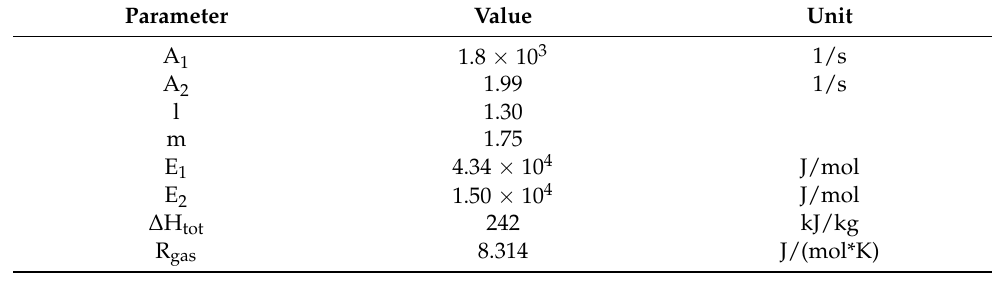
Table 4. Kinetics parameters estimated for the Elium 188-O/3%wt BPO system.